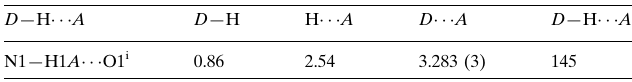
Hydrogen-bond geometry (A˚ , (cid:1)